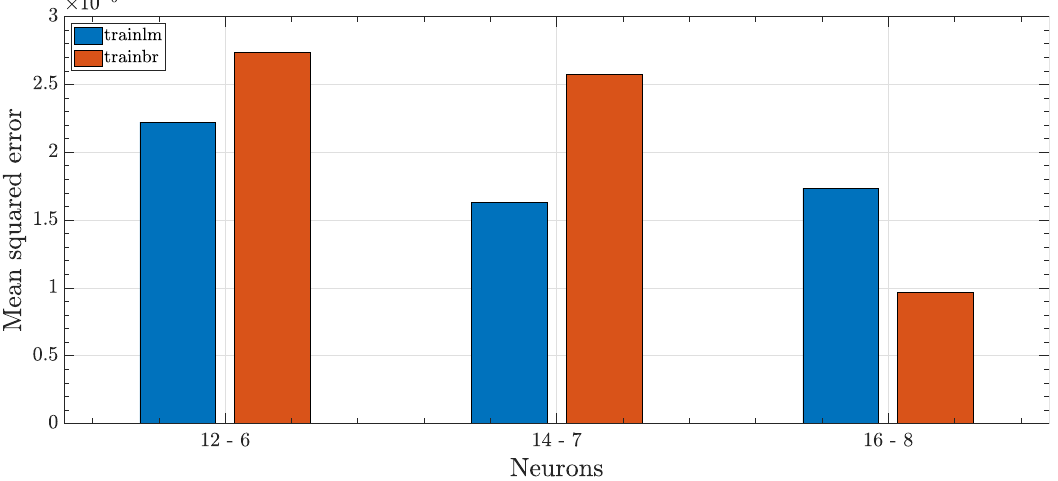
Figure 15. Double hidden layer networks performance as function of neurons and training function, sampling mode